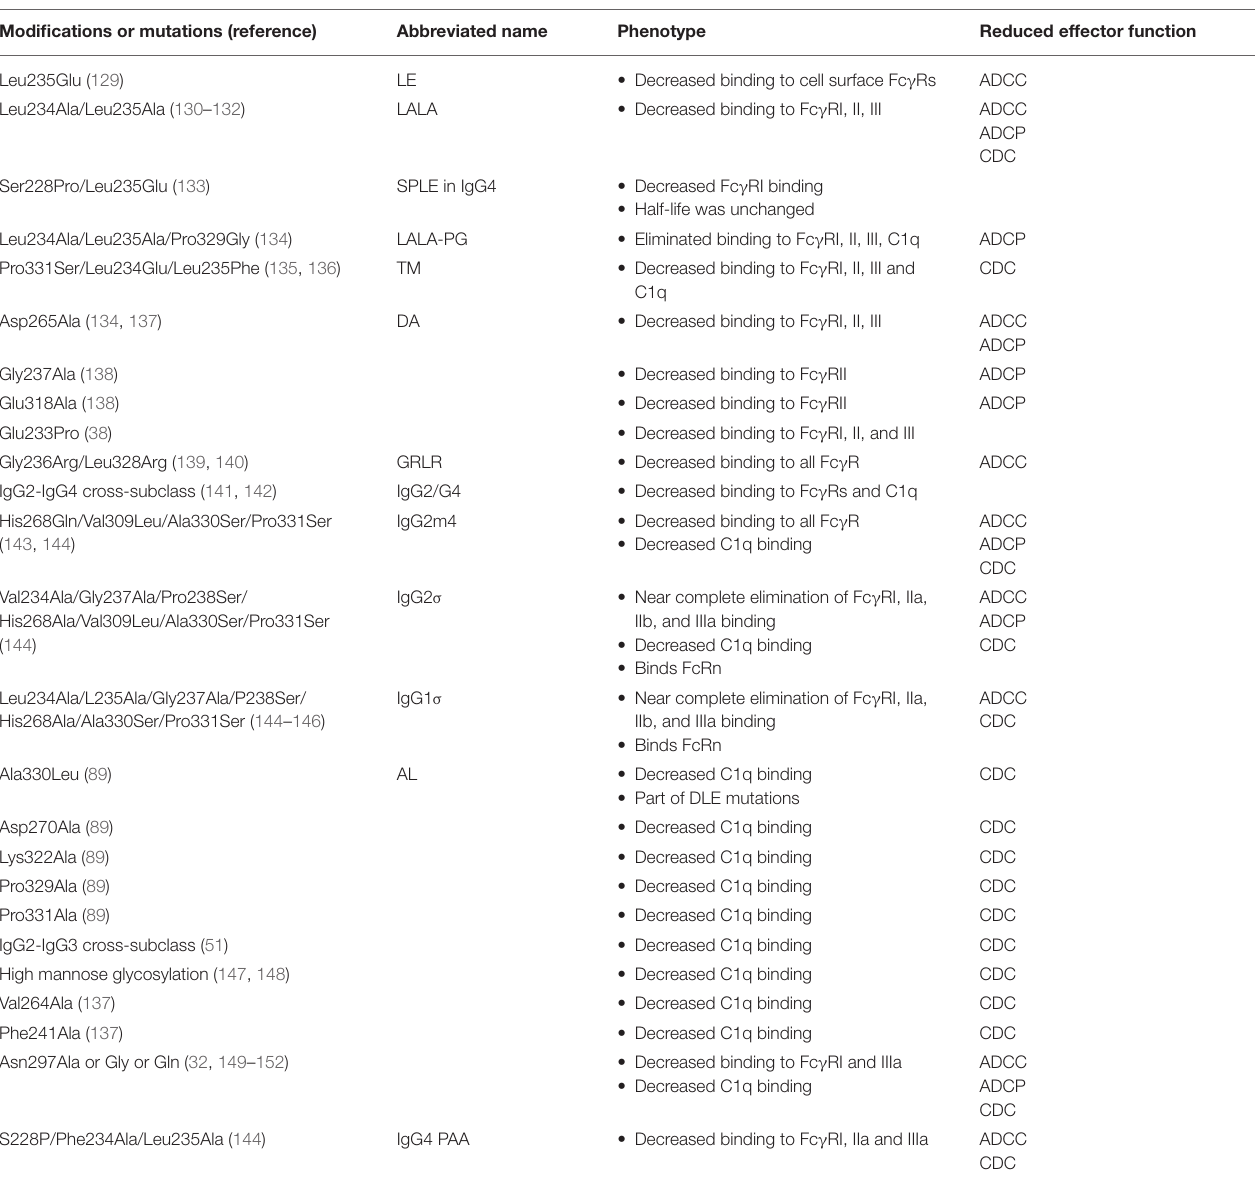
TABLE 3 | Fc modifications to silence antibody effector